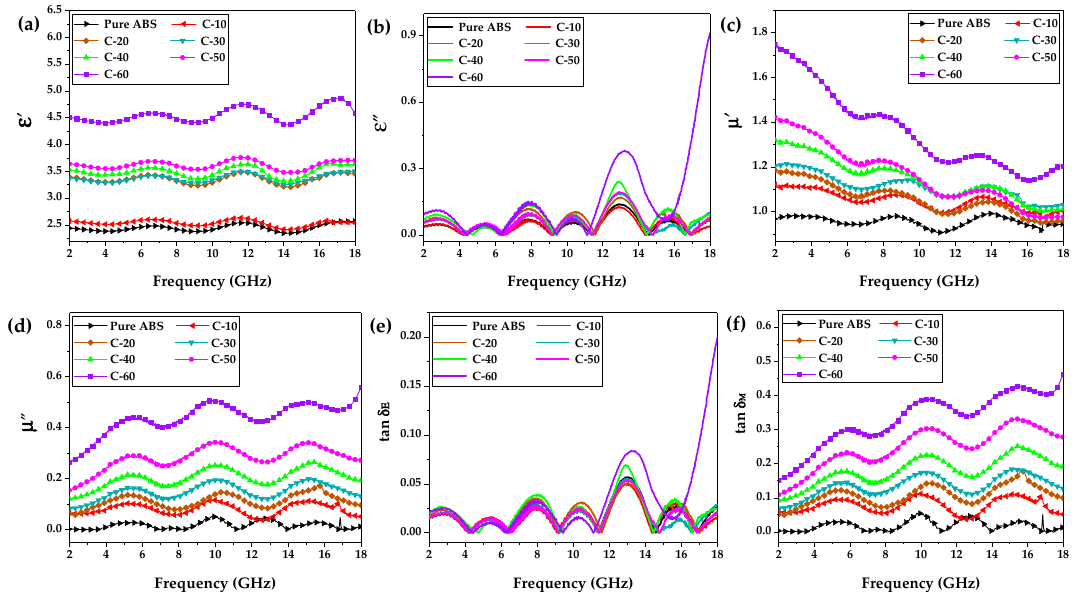
Figure 1. Electromagnetic properties of pure ABS, C-10, C-20, C-30, C-40, C-50, and C-60. ( a ) Real parts ( ɛʹ ) and ( b ) imaginary parts ( ɛʺ ) of the complex relative permittivity. ( c ) Real parts ( 𝜇ʹ ) and ( d ) imaginary parts ( 𝜇ʺ ) of the complex relative permeability. ( e ) The dielectric loss tangent tanδ (cid:3006) . ( f ) The magnetic loss tangent tanδ (cid:3014) .